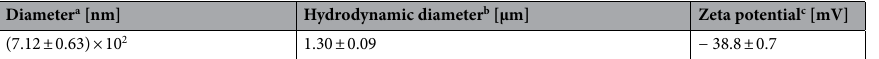
Table 1. Diameter of a particle produced 168 h after the mixture of the two solutions, and the hydrodynamic diameter and zeta potential of a particle dispersed in distilled water. The particles were synthesized setting the ratio of the molar concentration of (6,6)CNBs to that of C 60 molecules at 1:2 (the concentrations of (6,6)CNBs and C 60 molecules were, respectively, 0.35 and 0.70 µmol ml −1 ). a The diameter of the particles was measured, targeting at 100 particles from SEM images. b The hydrodynamic diameter of a particle dispersed in distilled water was measured by Zetasizer. c The zeta potential of a particle dispersed in distilled water was measured by Zetasizer.